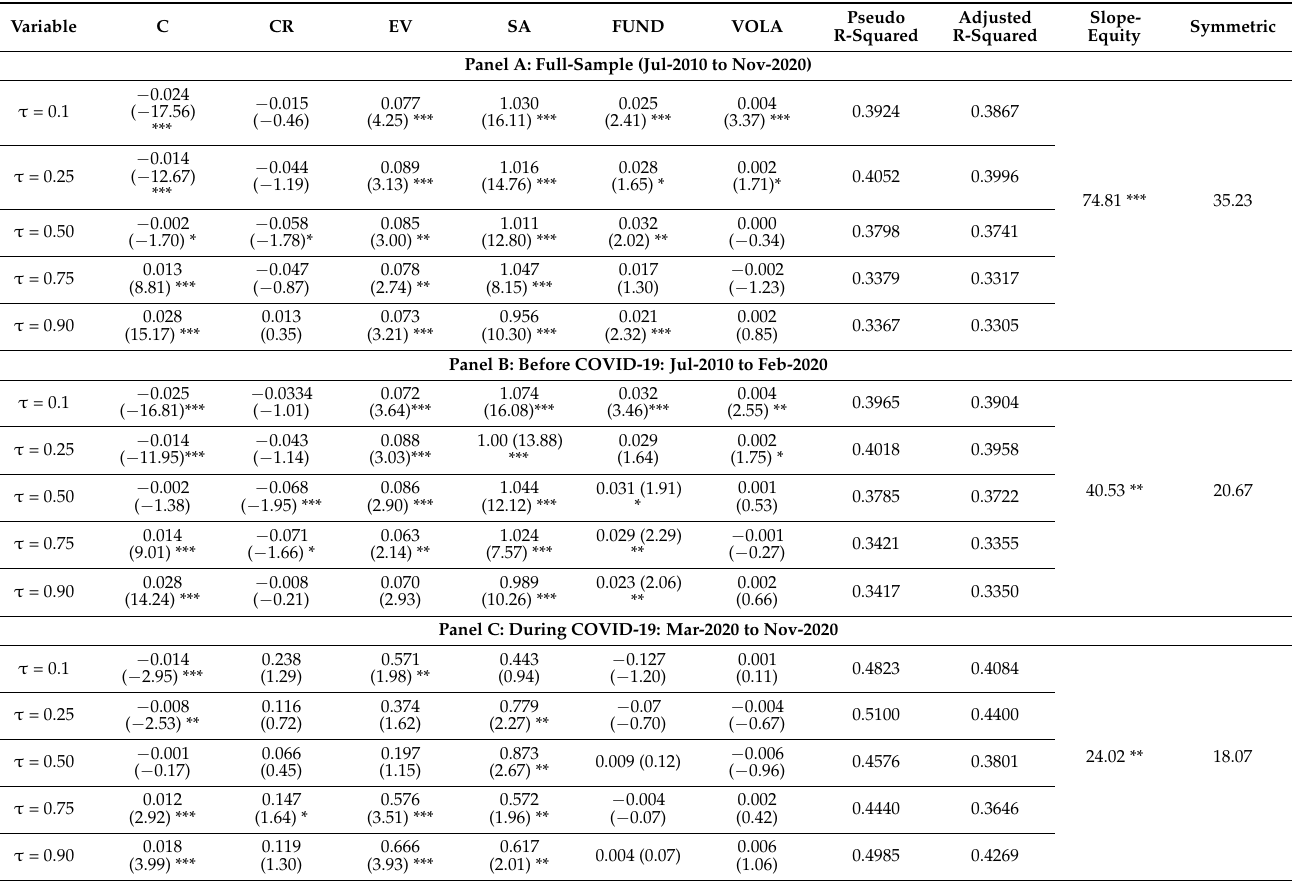
Table 4. QR Estimation of